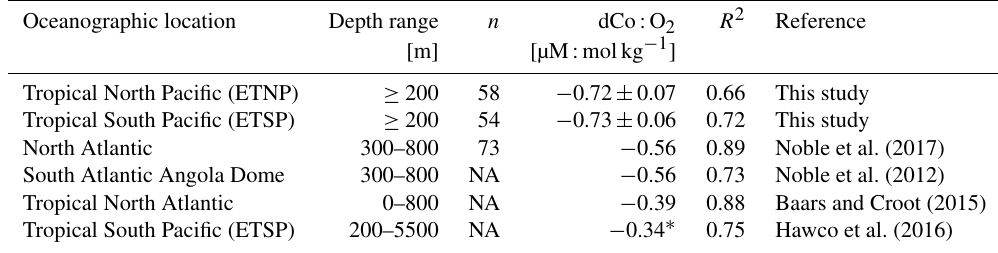
Table 3. Dissolved Co vs. O 2 correlation within OMZs in the Pacific GP15 transect (this study) and others. Oceanographic location